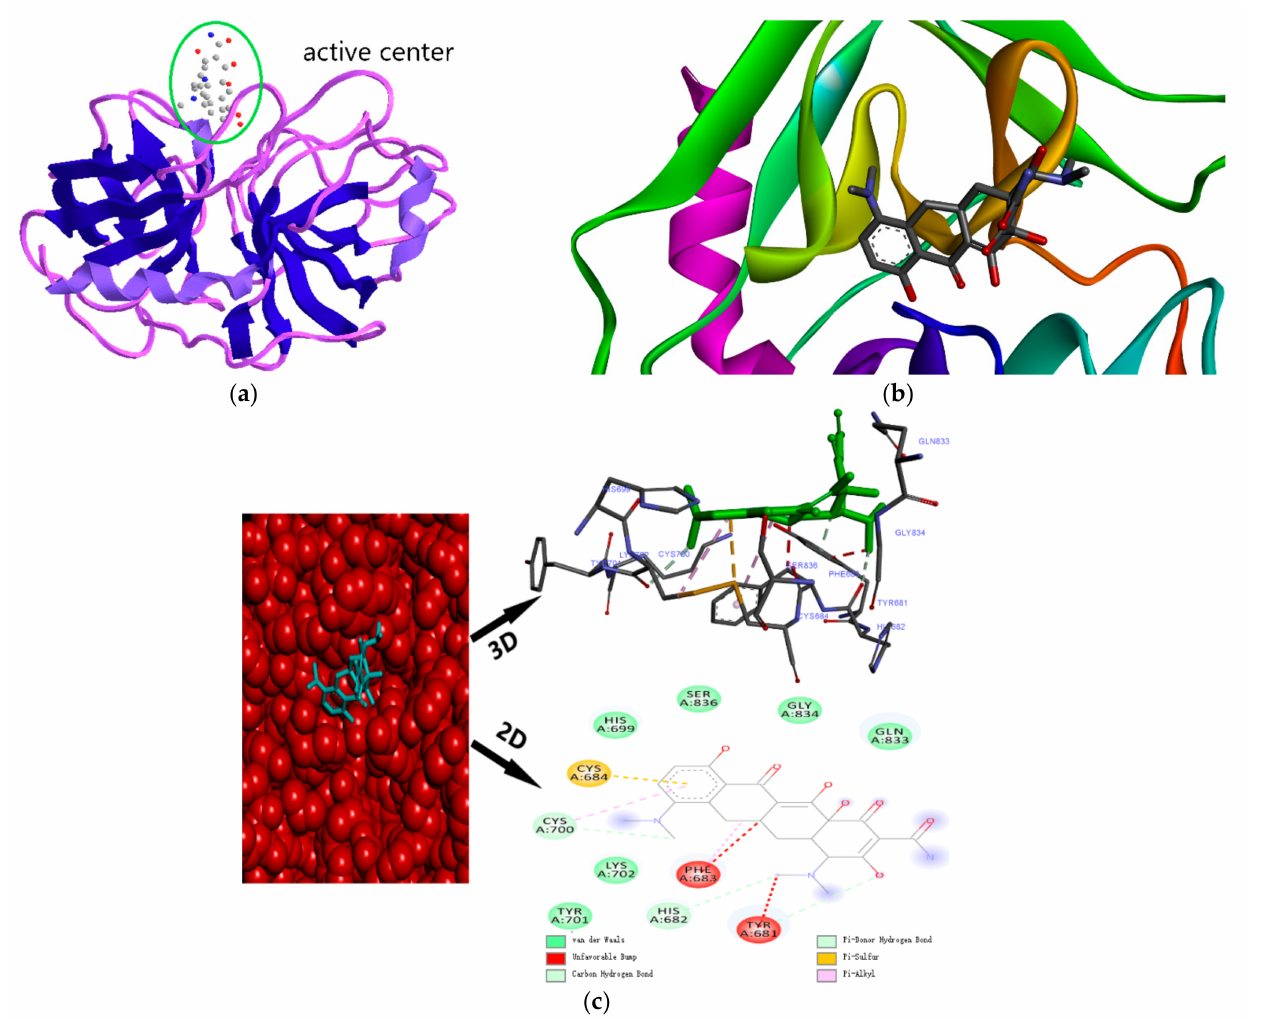
Figure 5. Molecular docking simulation of TRP and MC binding; ( a ) the molecular alignment diagram of MC and TRP; ( b ) the docking diagram of MC and TRP ribbon-like models; ( c ) the micro-environment 2D, 3D schematic diagram of MC combined with